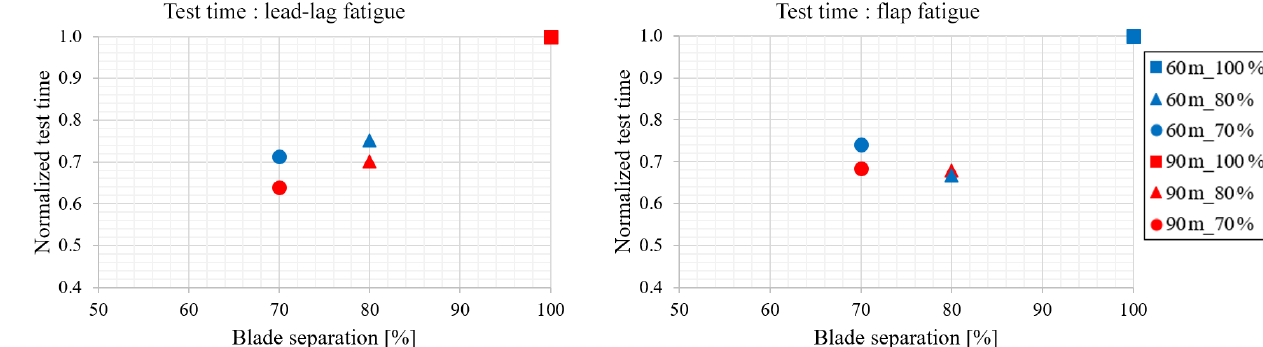
Figure 10. Normalized fatigue test time of blade root segments.